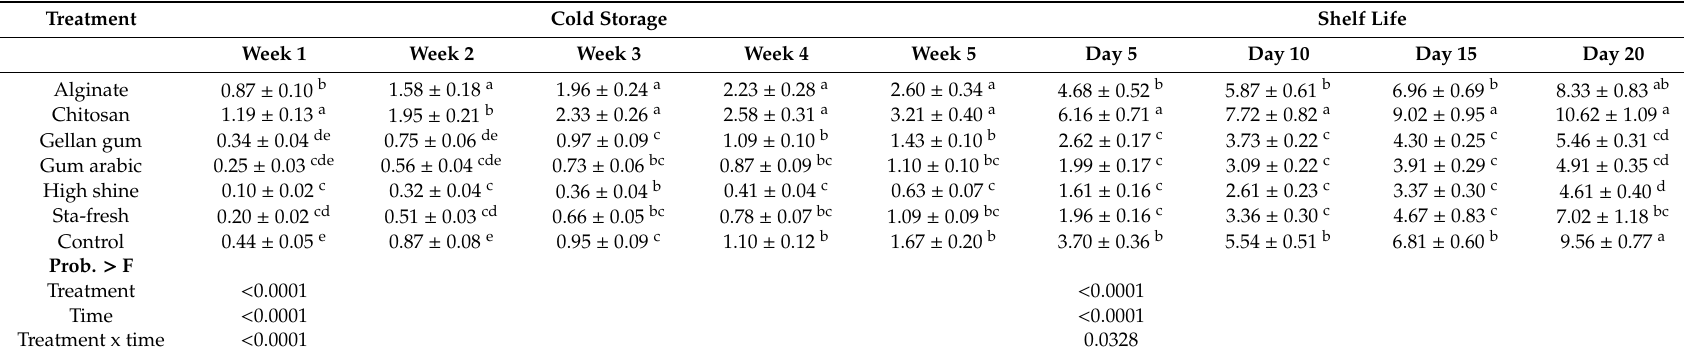
Table 1. Weight loss (%) in plums (‘African Delight ™ ’) during a simulated shipping period (cold storage; − 0.5 ± 2 ◦ C and 90 ± 5% RH for 5 weeks) and shelf life (20 ± 2 ◦ C and 75 ± 5%) RH for 20